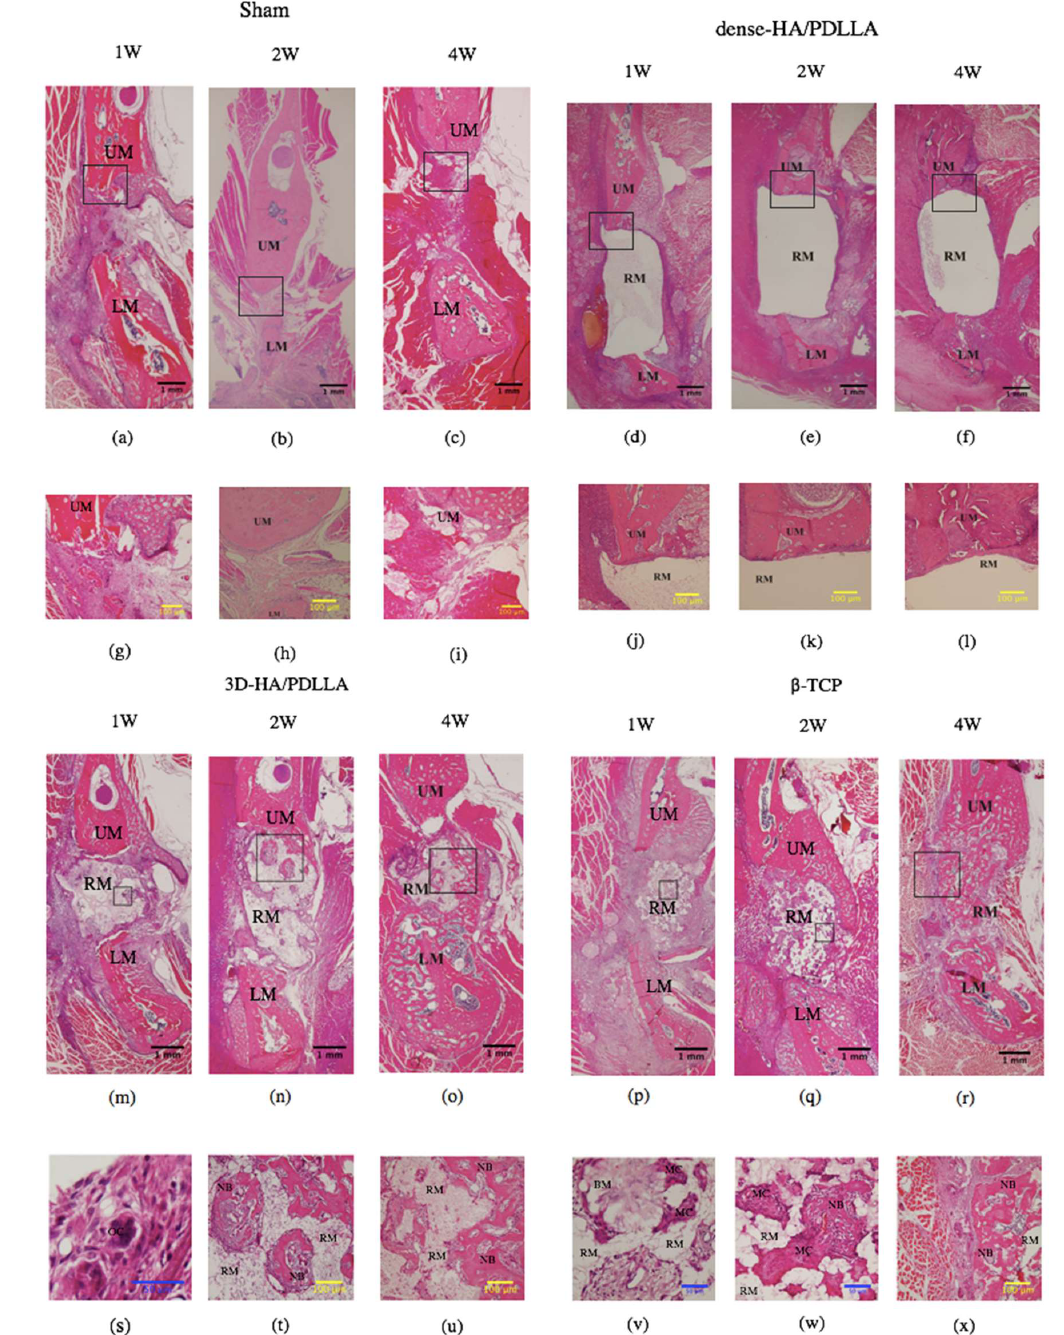
Figure 4. Hematoxylin and eosin staining of decalcified sections. Osteocyte-like cells are seen in the pores in the 3D-HA/PDLLA. The levels of bone formation are nearly identical in the 3D-HA/PDLLA and β-TCP groups. The blue arrowhead points to an osteoclastic-like cell in the pore of 3D-HA/PDLLA, and the black arrowhead to new bone formed in the pores of 3D-HA/DPLLA and beta-tricalcium phosphate (β-TCP). UM: upper mandible; LM: lower mandible; RM: residual material; OC: osteoclast-like cell; NB: newly formed bone; MC: multinucleated cell; BM: bone marrow-like tissue. ( a – c , g – i ) show the sham group; ( d – f , j – l ) show the dense-HA/PDLLA group; ( m – o , s – u ) show the 3D-HA/PDLLA group; ( p – r , v – x ) show the β-TCP group; ( a , d , g , j , m , p , s , v ) are at week 1; ( b , e , h , k , n , q , t , w ) are at week 2; ( c , f , i , l , o , r , u , x ) are at week 4; ( a – f , m – r ) are viewed under 1.25× magnification; ( g – l , t , u , x ) are viewed under 10× magnification; ( v , w ) are viewed under 20 × magnification; ( s ) is viewed under 40 × magnification. Scale bars: 1 mm (black), 100 µ m (yellow), and 50 µ m